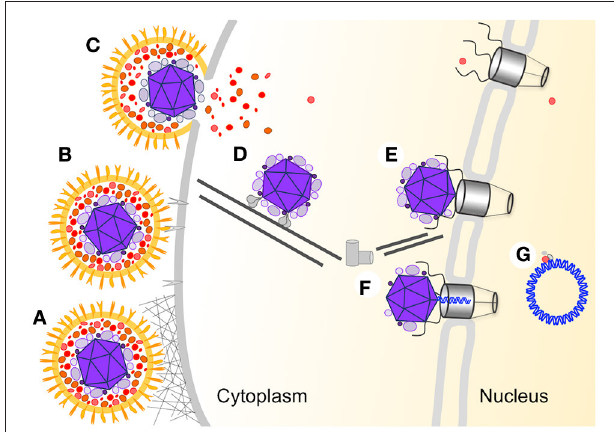
FIGURE 1 | HSV-1 multistep entry process . A schematic illustration of the different steps involved in the entry of HSV-1 into the host nucleus. The viral particle is colored orange (membrane and membrane protein), red (outer tegument layer), and purple (inner tegument and capsid), the viral DNA is in blue and all host proteins and structures are in different shades of gray. (A) Non-specific attachment between HSV-1 glycoproteins with heparan sulfate on the cell surface. (B) Specific binding between gD and the host specific receptors. (C) Fusion between the viral and host membrane. (D) Transport of the capsid to the nucleus is mediated by the viral inner tegument proteins interaction with cellular microtubule motor proteins. (E) Docking of the capsid to the nuclear pore complex (NPC). (F) Following conformational change in the capsid the viral DNA is translocated into the nucleus through the NPC. (G) The viral DNA adopt a circular conformation within the nucleus and viral gene expression is